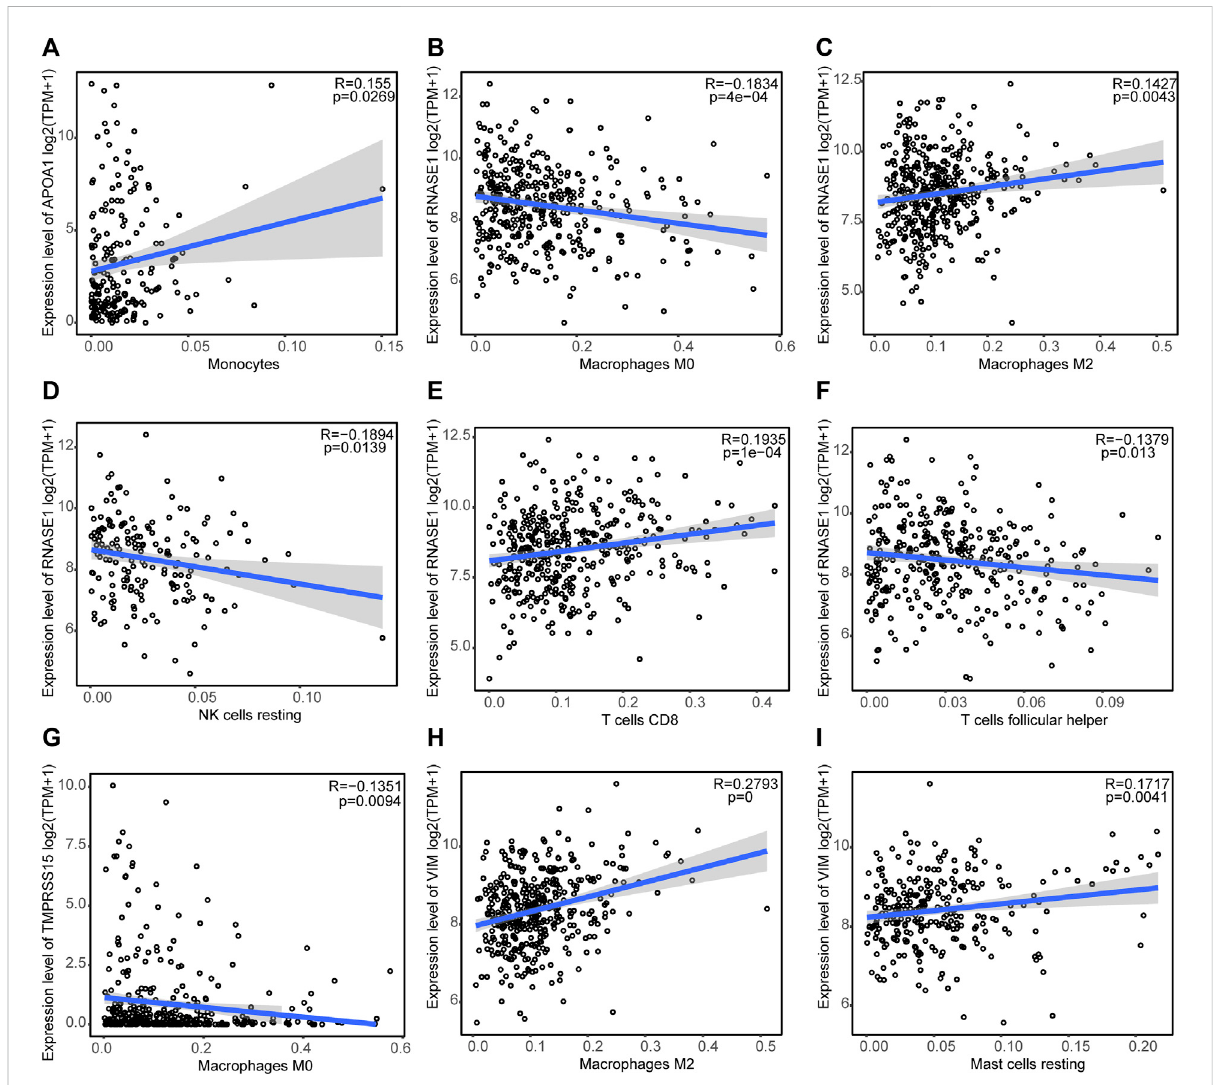
FIGURE 9 Correlations between the expression of prognostic genes and the levels of immune cell in fi ltration (A) Correlation between APOA1 expression andthemonocytein fi ltrationlevel.Correlationsbetween RNASE1 expressionandthein fi ltrationlevelsof (B) M0macrophages, (C) M2macrophages, (D) restingNKcells, (E) CD8Tcells,and (F) follicularhelperTcells. (G) Correlationbetween TMPRSS15 expressionandtheM0macrophagein fi ltration level. Correlations between VIM expression and the in fi ltration levels of (H) M2 macrophages and (I) resting mast